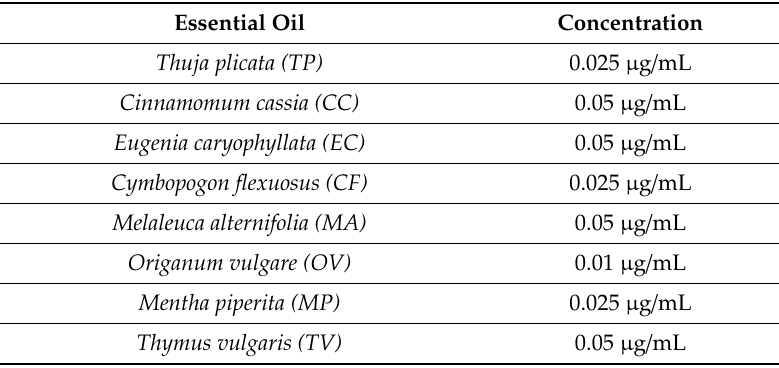
Table 2. Used essential oils their highest noncytotoxic